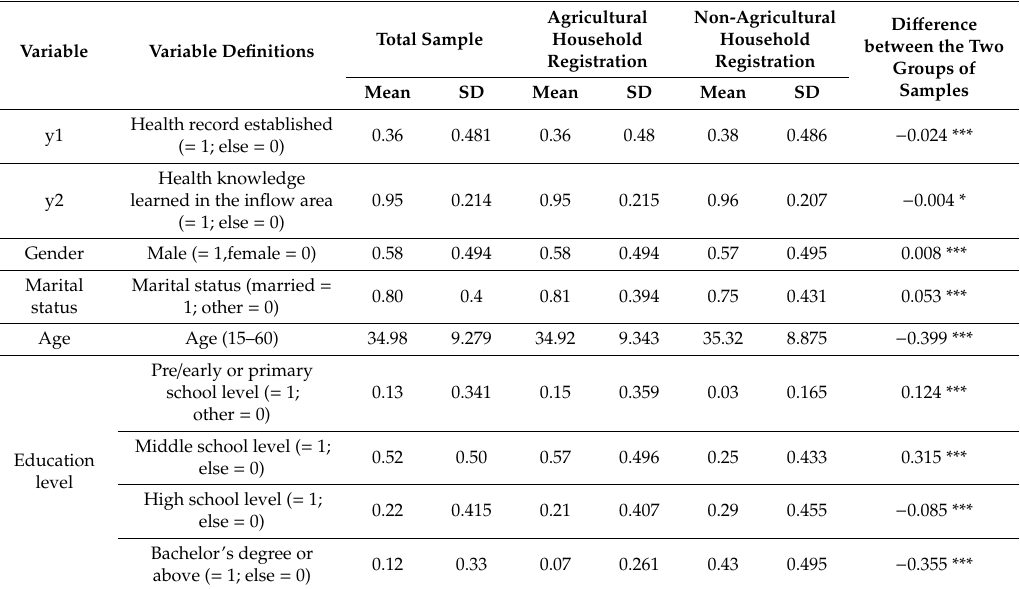
Table 1. Sample definitions and descriptive